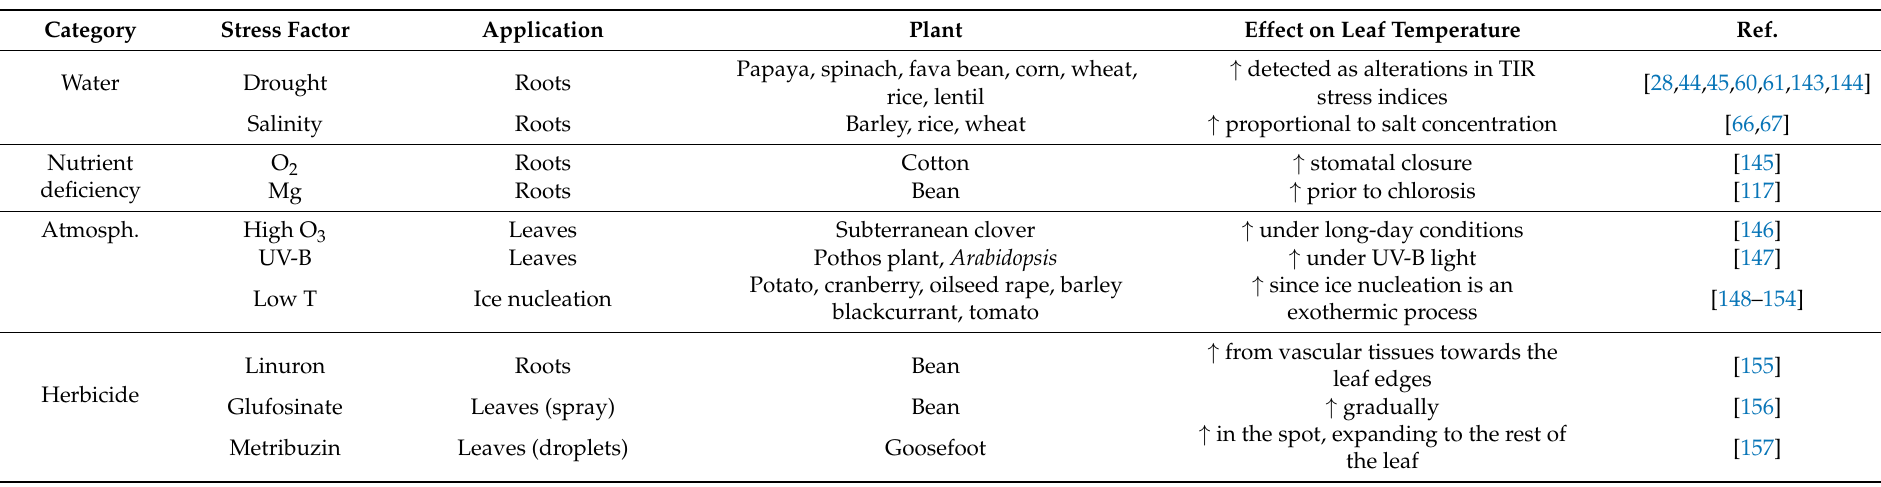
Table 3. Effects of several abiotic stress factors on leaf temperature as measured by thermography at proximal sensing scale. Arrows ( ↑ ) denote increment in leaf temperature due to the stress